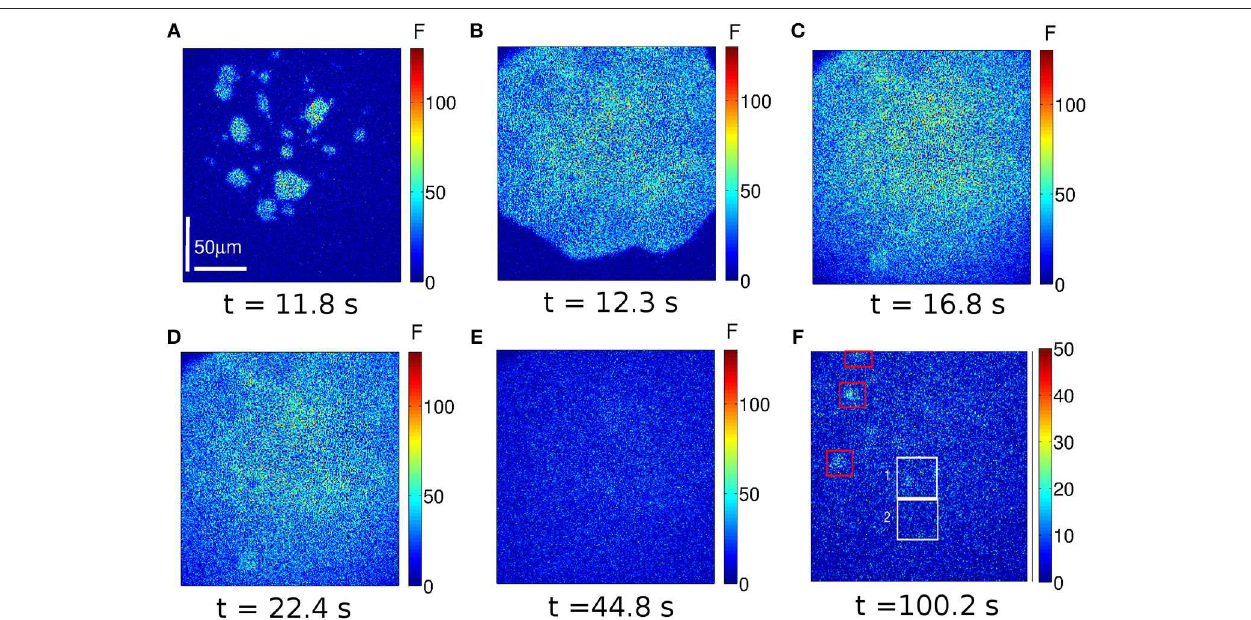
FIGURE 2 | Example of a Ca 2 + signal evoked in an immature oocyte. Frames of 250 increasing fluorescence values in arbitrary units ( a . u .). The UV illumination (used to uncage the IP 3 ) was on between t and t 190.4s. At t 11.8 s various localized Ca 2 + elevations ( spotlights ) are apparent (A) . They eventually lead to a wave (B) that propagates throughout the = ∼ observed region. The maximum fluorescence level is reached at t flash is turned off ( t 28 s) the fluorescence decays rapidly until it reaches the basal level by t = UV flashes as illustrated in (F) . The white boxes indicate two regions analyzed in Figure 4